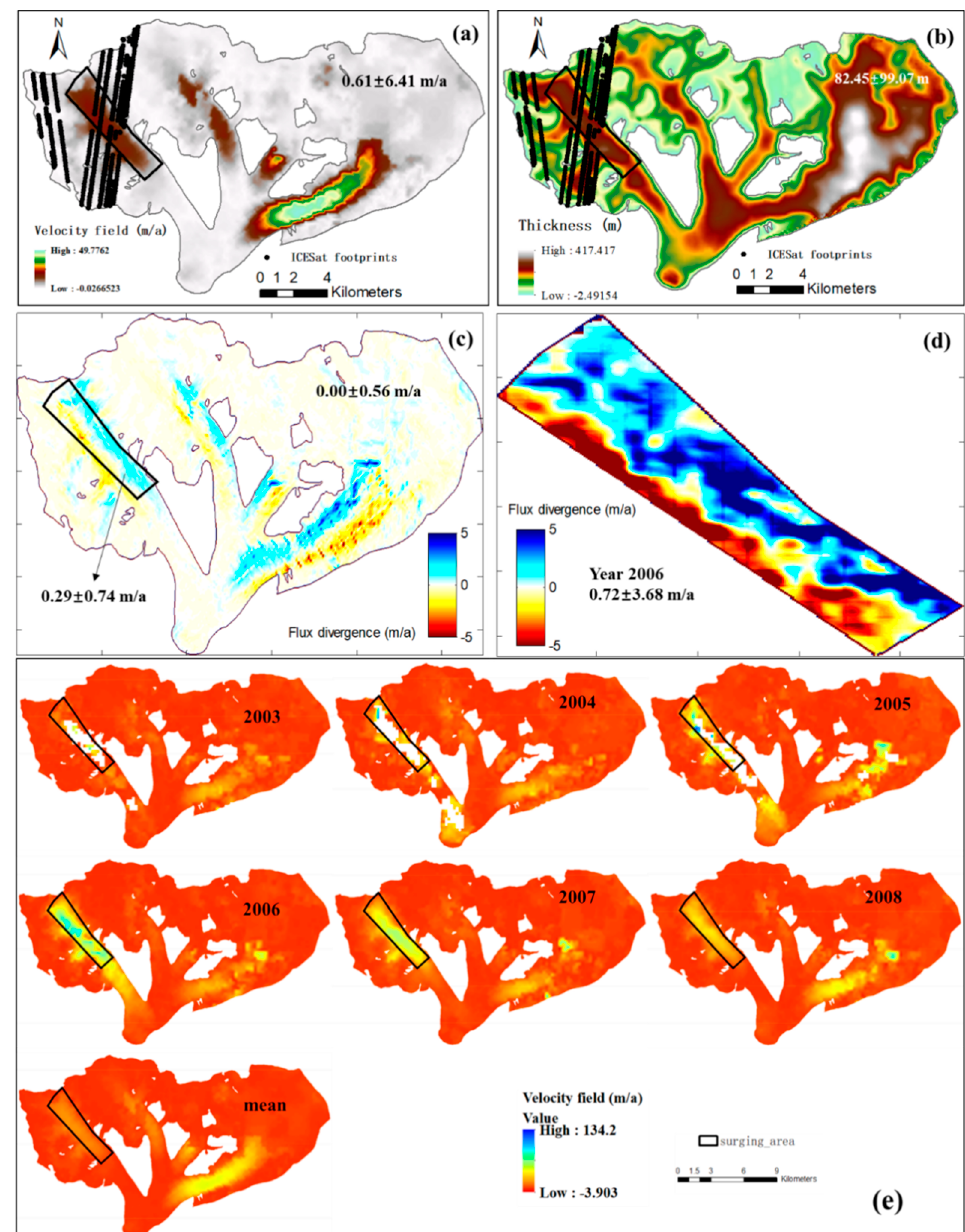
Figure 8. Glacier velocity ( a ), thickness ( b ), and flux divergence ( c , d ), and surface velocity field time series ( e ) of Zhongfeng glacier.